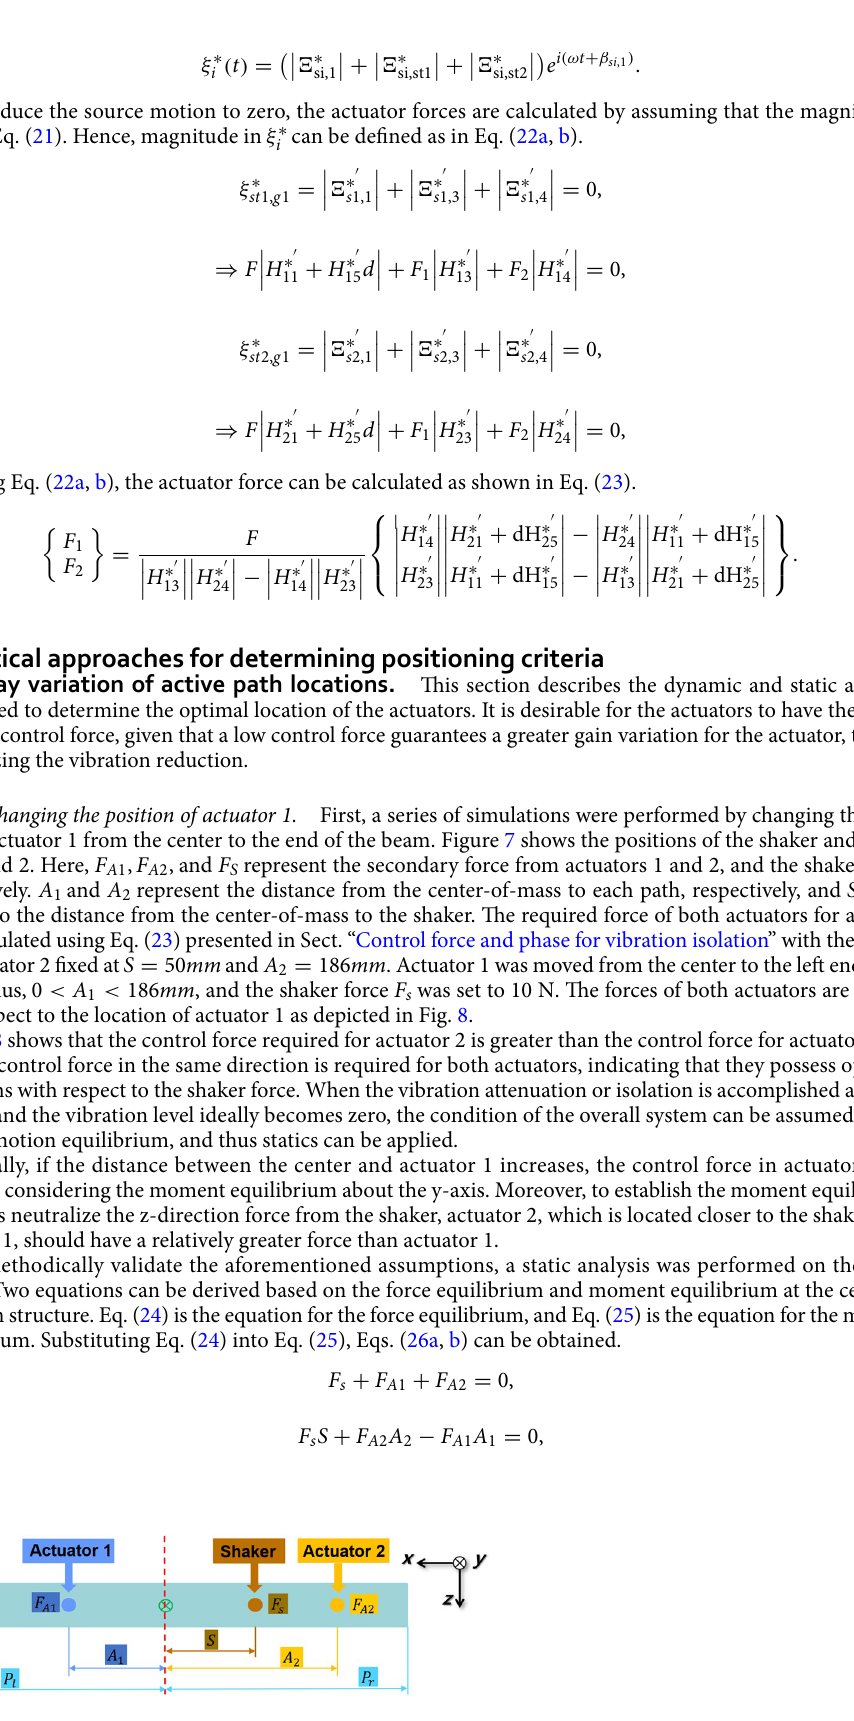
Figure 7. Positions of shaker, actuator 1, and actuator